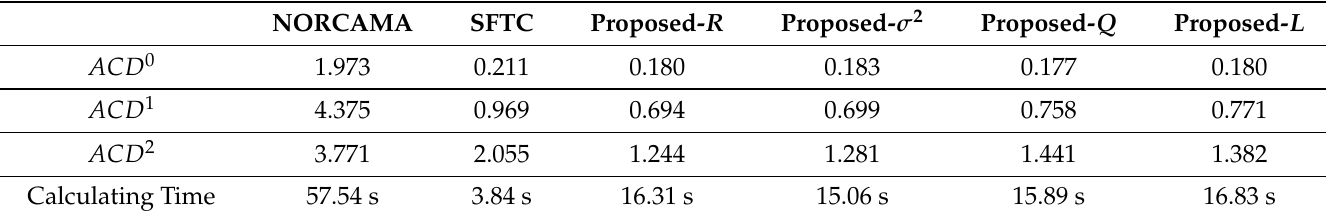
Table 5. Numerical results of the various methods using data